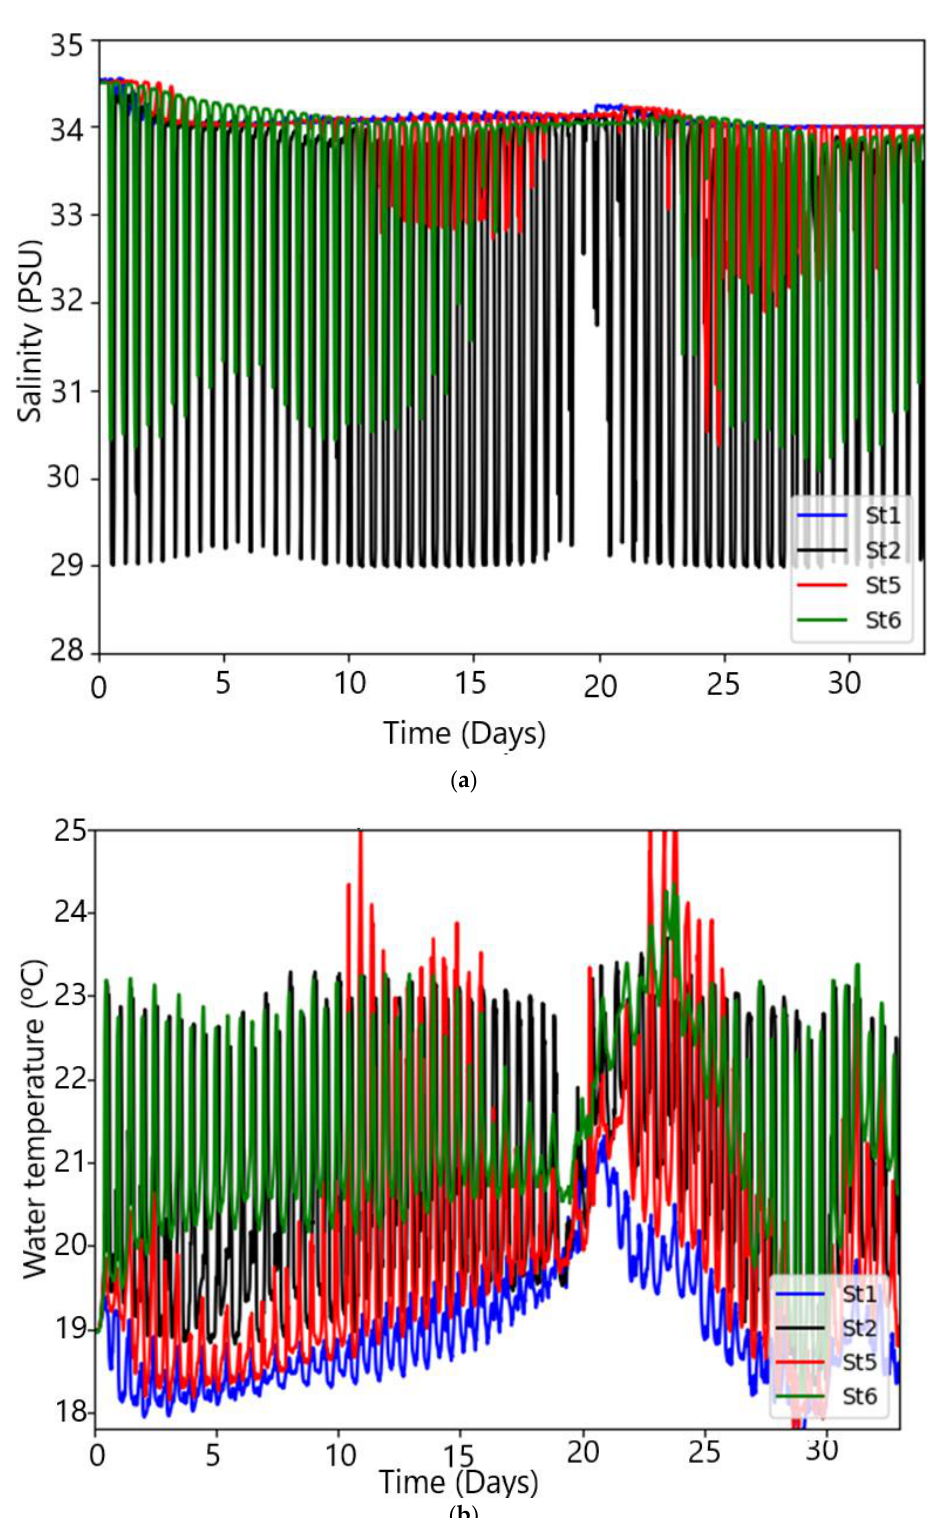
Figure 3. ( a ) Simulated salinity for June 2001, simulated for St1, St2, St3, and St4. ( b ) Simulated water temperature for June 2001, for St1, St2, St3, and St4.